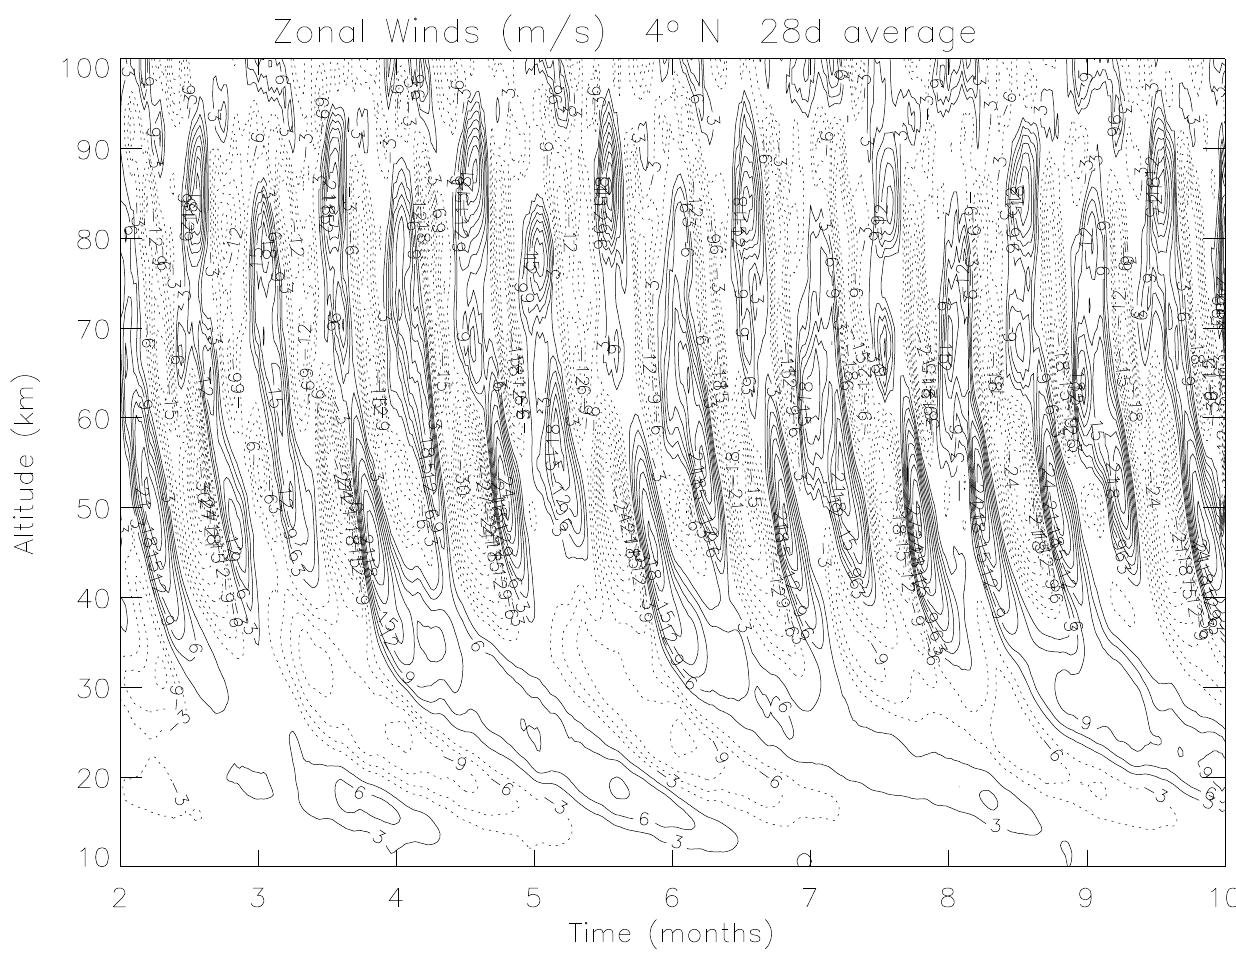
Fig. 2. Equatorial oscillations generated by GWs. The QBO period is close to 28 months, near the middle of observed values, but its amplitude is relatively small. (Numerical experiments show that more realistic QBO amplitudes can be produced with a latitude dependent GW source that is enhanced at the